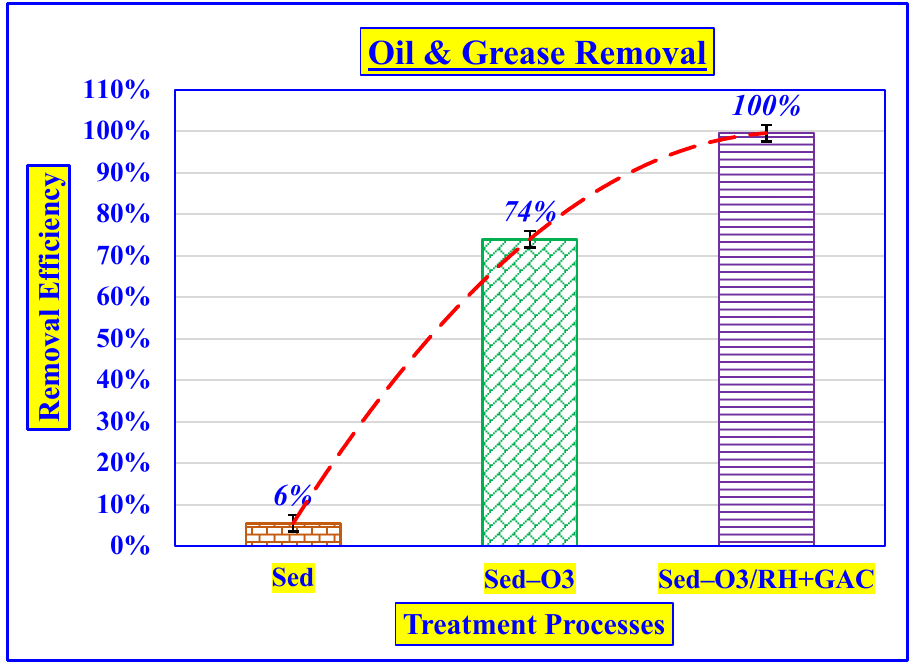
Figure 11. Oil and Grease removal by hybrid system (Initial O and G = 200 mg/L; O3 = 82.5 ± 2.2 mg/L; peristaltic pump speed = 150 rpm; C.T = 18 min; GAC = 200 g; RH = 200 g; pH = 6.9 ± 0.2; volume = 4 L; T = 25 ± 2 C).